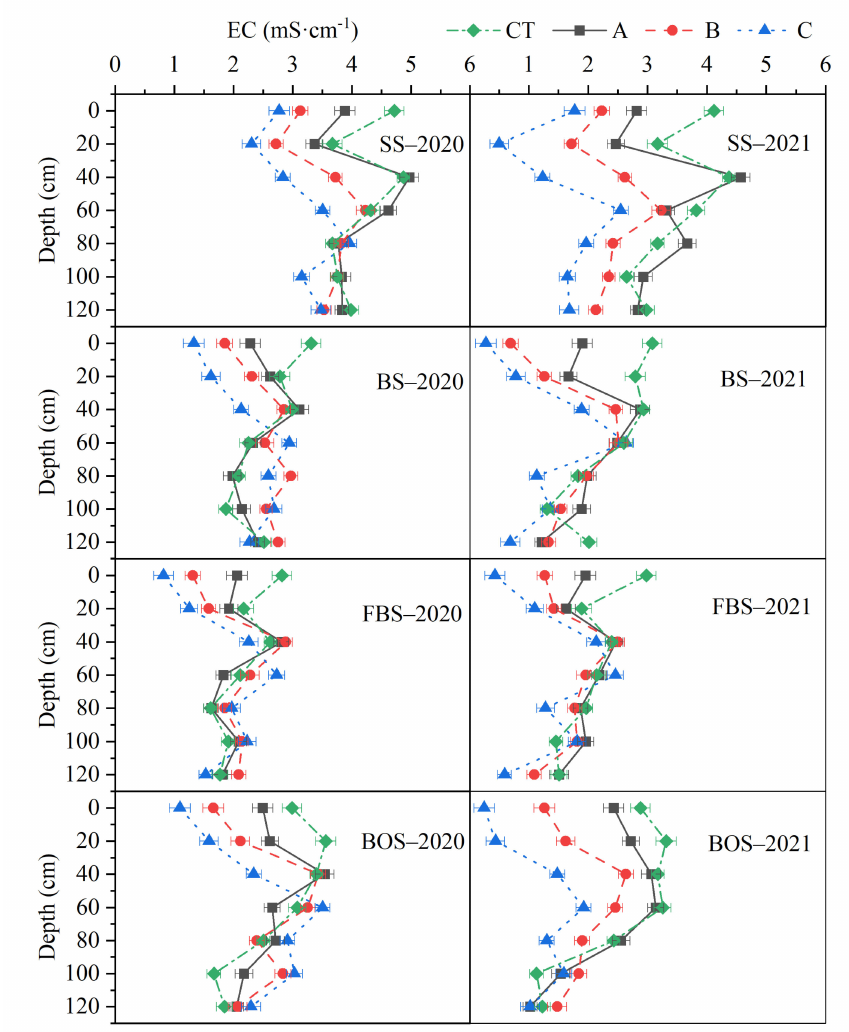
Figure 5. Comparison of soil salinity levels under different smashing ridge tillage depth treatments during the growth periods in 2020 and 2021. Data (mean ± SD) were collected from soil depths between 0 and 120 cm. CT, conventional tillage; A, 20 cm; B, 40 cm; C, 60 cm. SS, seedling stage; BS, bud stage; FBS, flowering and boll stage; BOS, boll opening